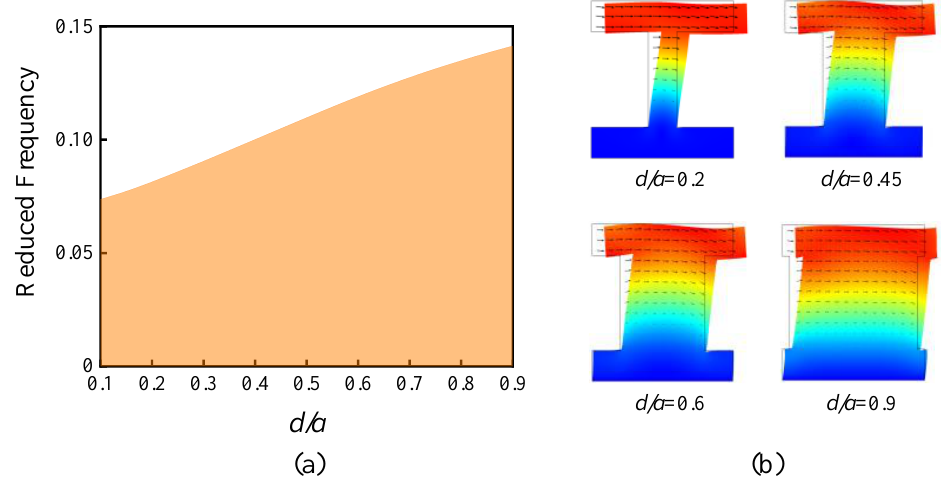
Figure 8. Relationship between the band gap characteristic and the parameter ratio d / a . ( a ) Relationship function curve and ( b ) eigenmode displacement vector field.